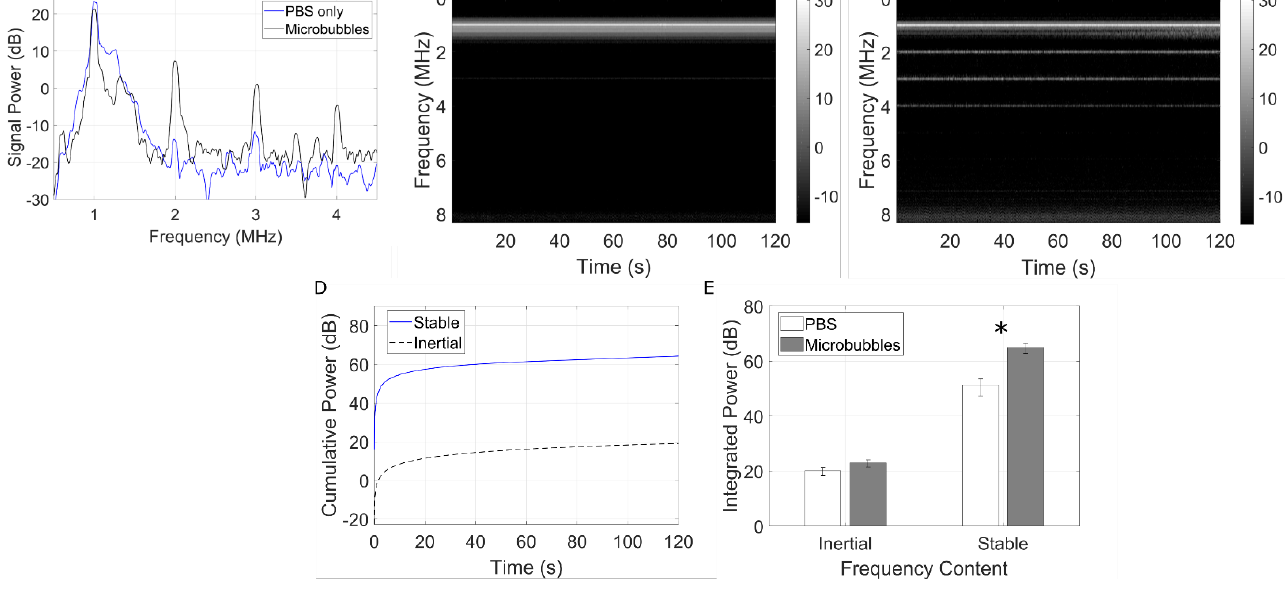
Figure 5. Microbubbles undergo stable cavitation during gene delivery treatment. ( A ) The mi- crobubble echo spectrum at the beginning of treatment (black line) as compared to a PBS only control (blue line). ( B ) Time-frequency plots of the resulting cavitation echoes in PBS (control) and ( C ) miR-126 loaded microbubbles. This time-frequency depiction clearly shows prolonged harmonic content (stable cavitation) throughout the 2 min treatment, and the absence of any broadband spectral emissions (inertial cavitation). ( D ) Quantification of the cumulative spectral power from the stable (blue, solid line) and inertial (black, dashed-line) cavitation frequency bands over the total treatment time of a given sample. ( E ) Quantification over all samples compared to PBS only controls. Asterisks denote statistical significance ( p < 0.02).